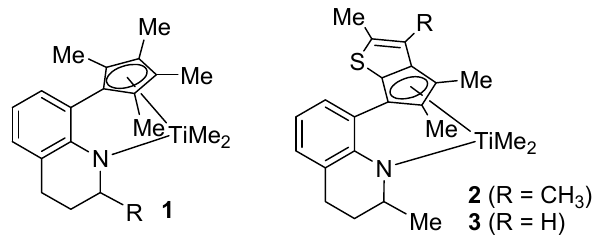
Figure 1. Highly active catalysts for ethylene/ α -olefin